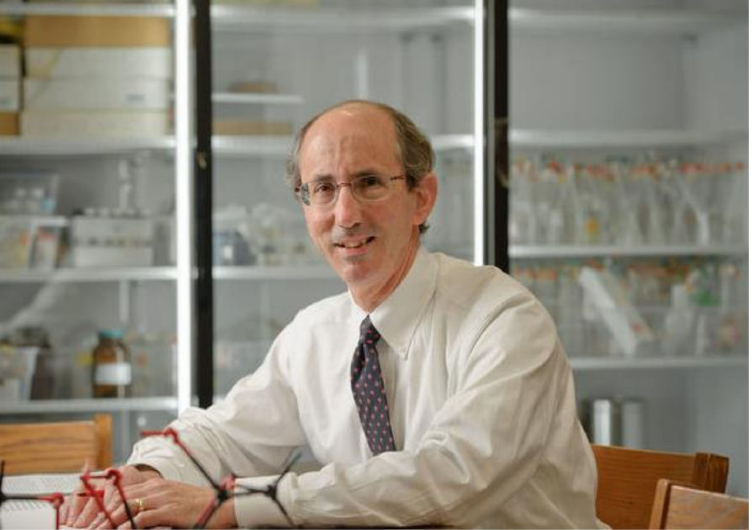
Figure 1. Professor Anthony S. Serianni, University of Notre Dame, USA. Adopted from the official site of the University of Notre